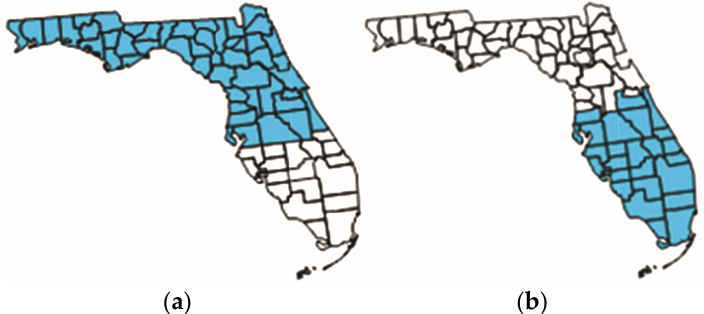
Figure 1. Planting regions in Florida for E. amplifolia ( a ) and C. torelliana ( b ) from [5].